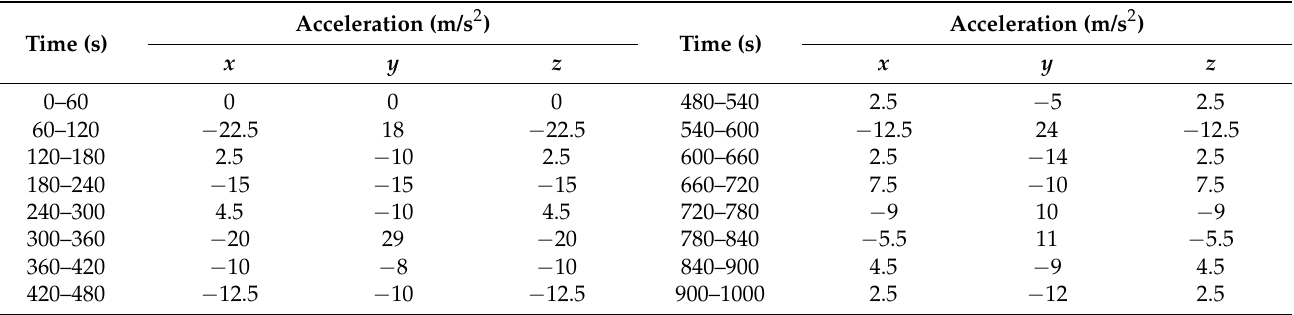
Table 9. Maneuver parameters of the